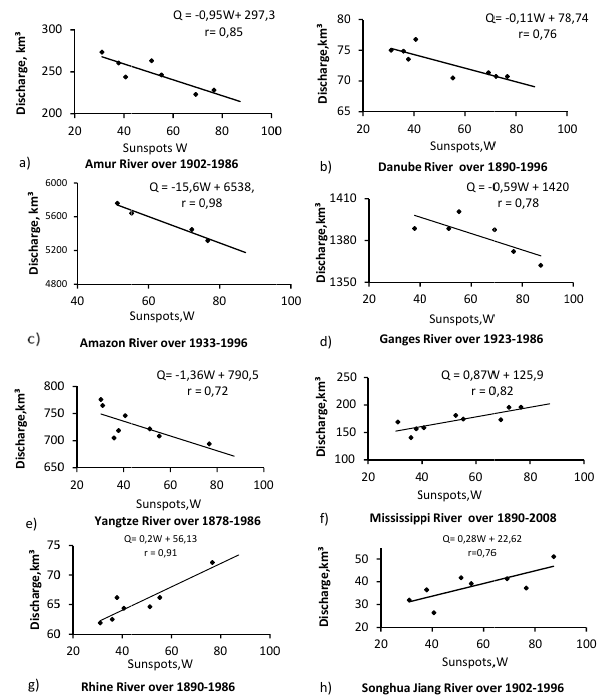
Figure 5. Relationships of rivers discharge in dependence on solar